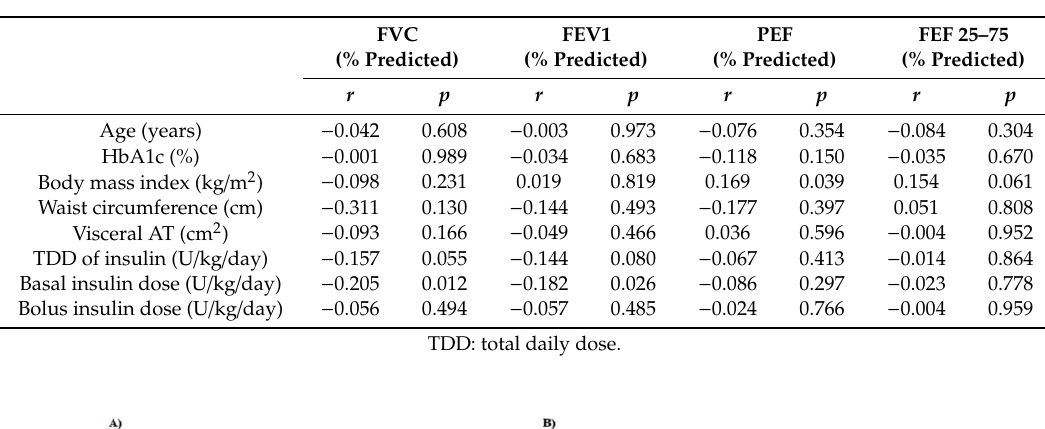
Figure 1. Scatter plot showing the linear correlation between pulmonary parameters (forced vital capacity and forced expiratory volume in the first second) and daily units per kilogram of body weight (U / kg / day) of basal (blue circle) and bolus (yellow circle) insulin. ( A ) FVC (% of predicted), ( B ) FEVI (% of predicted). Table 4. Bivariate correlation between pulmonary parameters and relevant medical information in patients with type 1 diabetes.